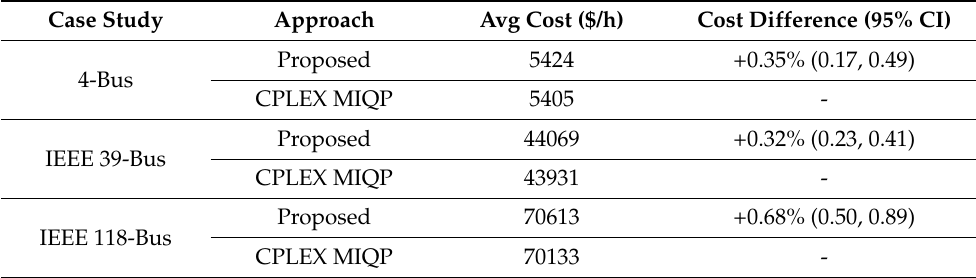
Table 12. Cost Comparison.